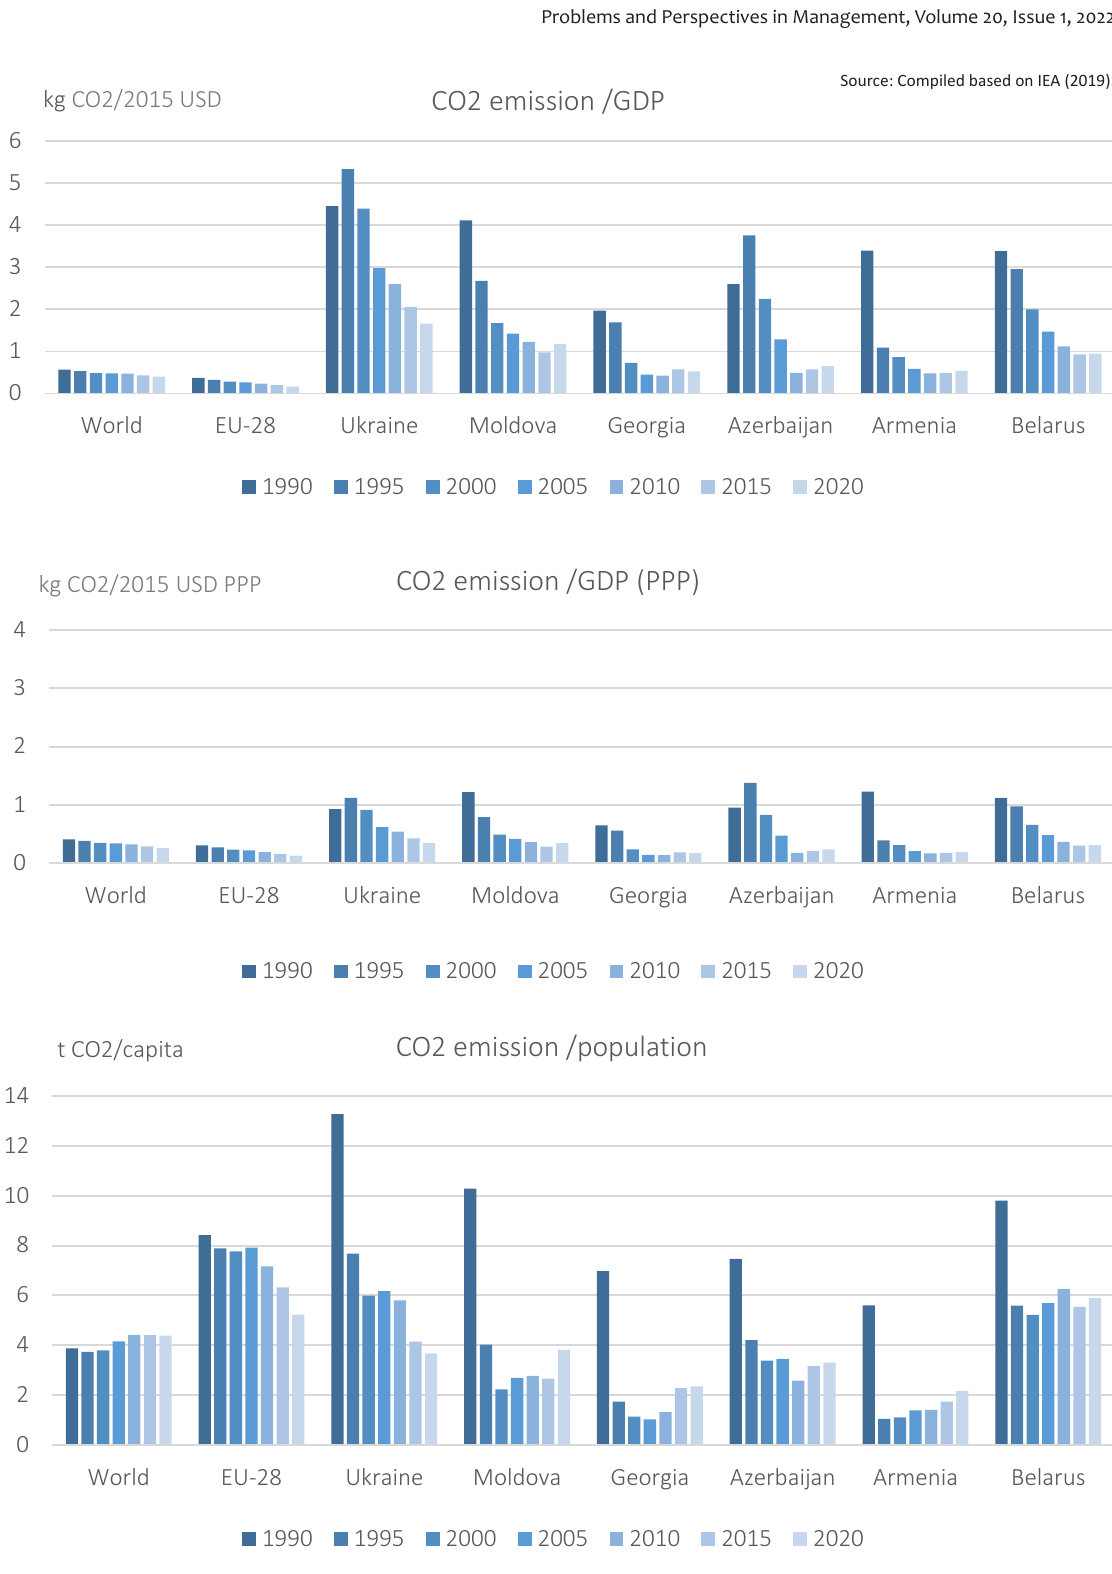
Figure 9. Carbon intensity in the world, European Union, and the countries of the EU’s